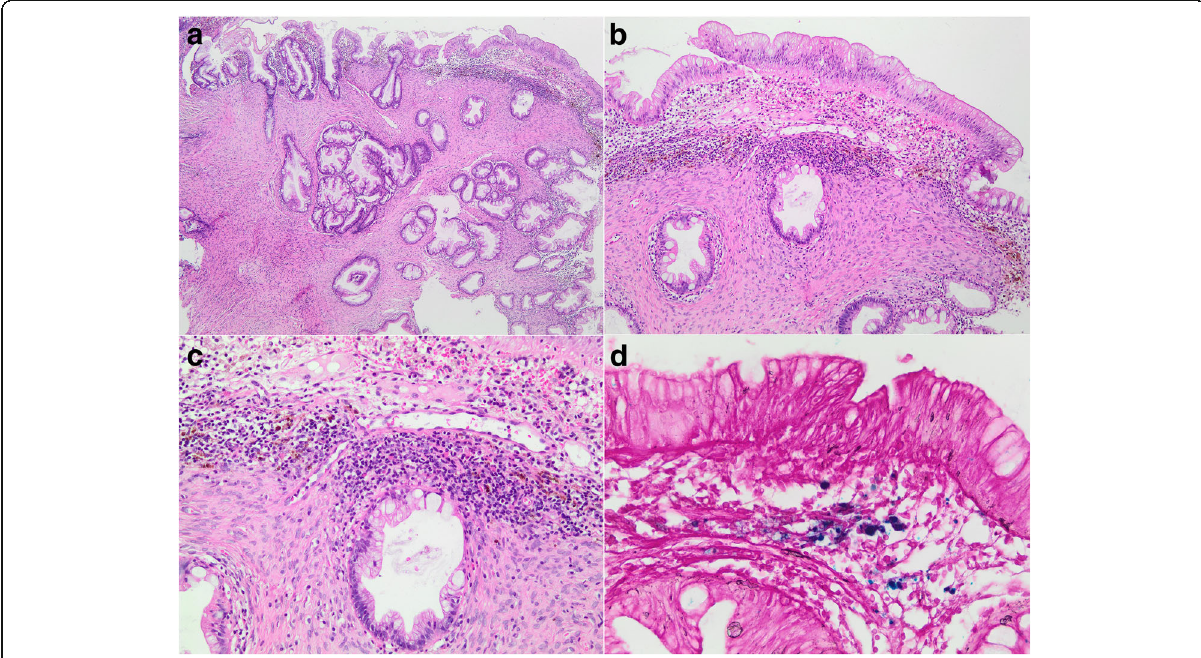
Fig. 1 Histological findings. a A proliferation of benign-appearing eosinophilic spindled cells expanded the lamina propria and separated colonic crypts with serrated architecture (haematoxylin and eosin, original magnification 40×). b The proliferation of spindled cells was separated from the surface epithelium by a zone of uninvolved but inflamed lamina propria (haematoxylin and eosin, original magnification 100×). c Conspicuous hemosiderin deposition occurred at the interface of the spindle cell proliferation and the inflamed lamina propria (haematoxylin and eosin, original magnification 200×). d A Perls ’ Prussian blue stain confirmed the presence of hemosiderin (original magnification